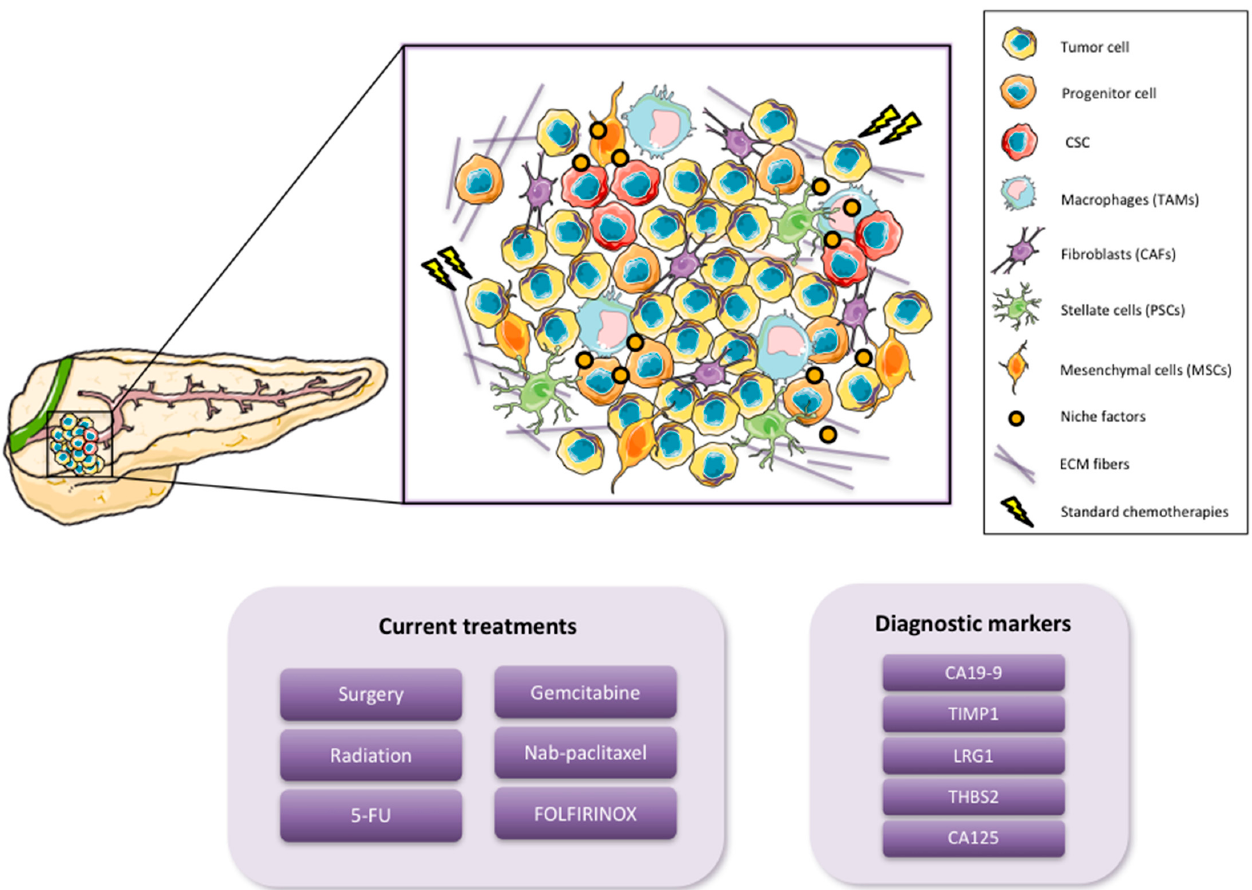
Figure 1. Pancreatic Ductal Adenocarcinoma (PDAC) tumor complexity, diagnosis and treatment. PDAC tumors include several cell types that interact with one another to maintain the tumor and facilitate PDAC progression. The tumor microenvironment plays a critical role in supporting tumor maintenance and expansion. The major cell types that belong to the PDAC tumor microenvironment are Tumor-associated macrophages (TAMs), Cancer-associated fibroblasts (CAFs), Pancreatic stellate cells (PSCs) and Mesenchymal stem cells (MSCs). Standard of care treatments only affect the tumor bulk, and diagnostic markers still lack sensitivity to adequately diagnose PDAC at early stages.